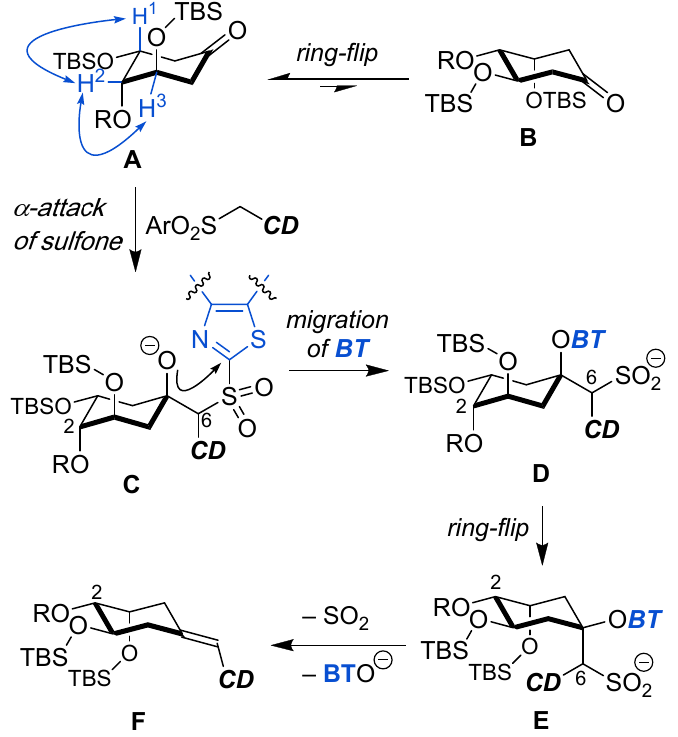
Scheme 2. Conformational analysis of the A ring ketones 5 and mechanism of the Julia-type olefina- tion.